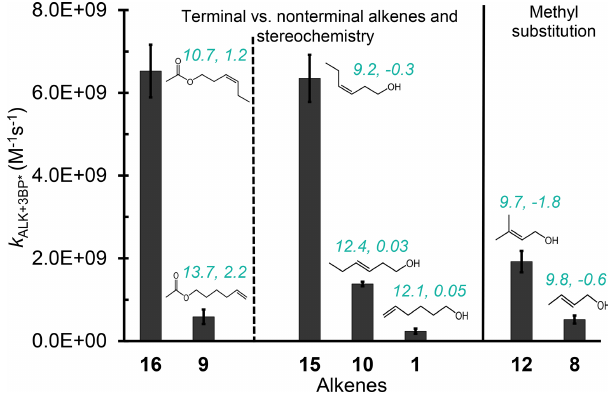
Figure 2. Comparison of three sets of alkenes to illustrate how rate constants with the benzophenone triplet state vary with double bond location, stereochemistry, and methyl substitution. The teal num- bers on each alkene represent the lowest free energy ( (cid:49) G ‡ ) and enthalpy ( (cid:49) H ‡ ) transition-state barriers in kcalmol − 1 for H ab- straction by the triplet benzophenone; these were calculated at the uB3LYP/6-31 + G(d,p) level of theory. Though computed barriers (Table 1) are not correlated with the overall rates measured, they broadly match the rate trends within a given set of alkenes in this